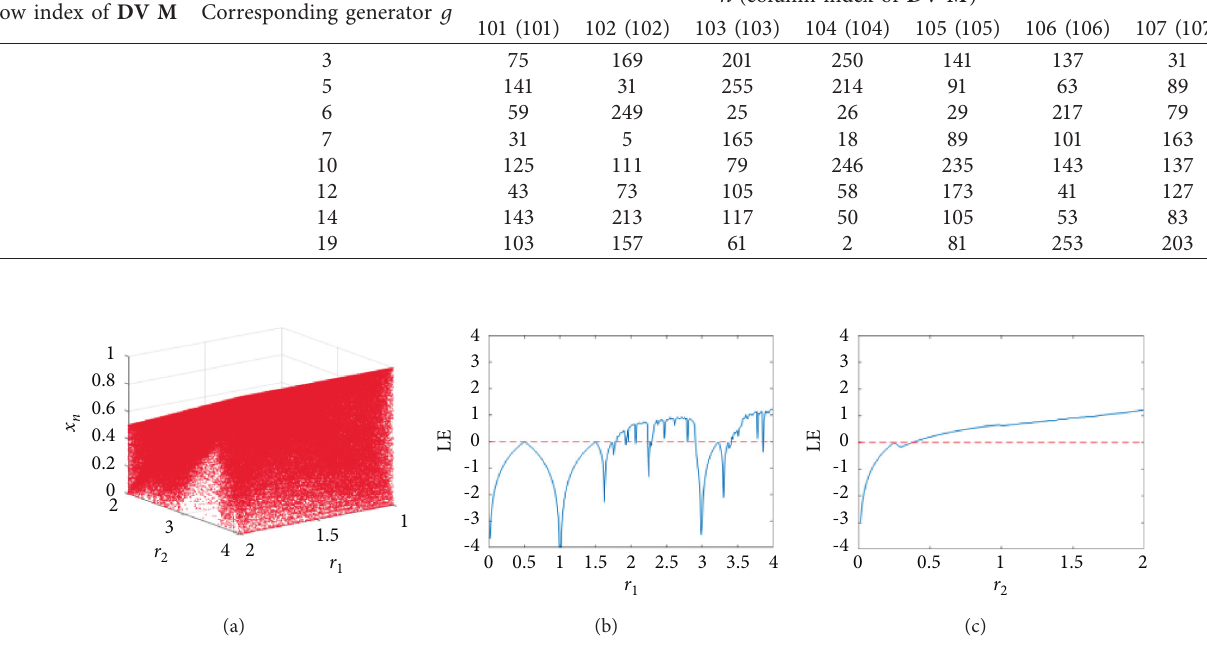
Figure 1: 2D bifurcation diagram and LE diagrams of TLM: (a) 2D bifurcation diagram; (b) LE diagram versus parameter r . versus parameter r 2